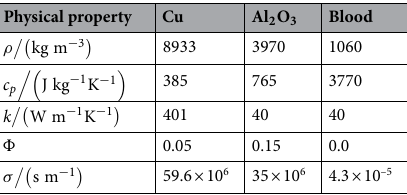
Table 1. The nano-particles’ thermo-physical properties and micro polar